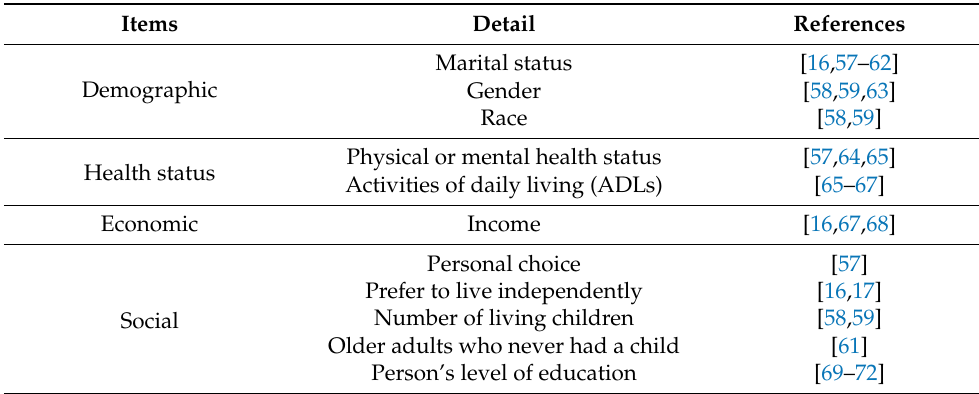
Table 1. Factors correlated to living alone in older